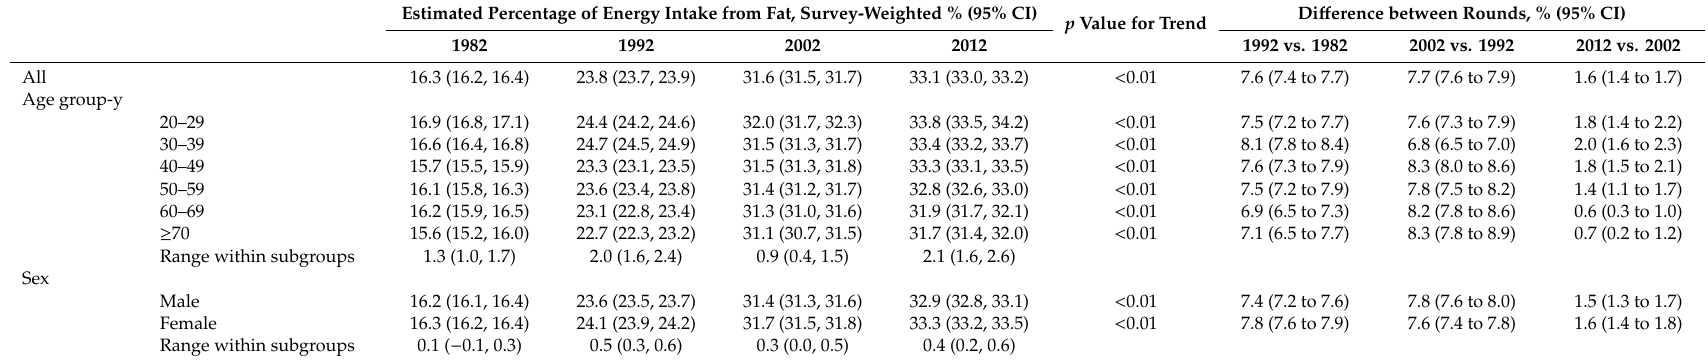
Table A2. Trends and Disparities in the Estimated Percentage of Energy Intake from Fat of Adults Aged 18 Years or Older by CNNS Round, 1982–2012 1 . Estimated Percentage of Energy Intake from Fat, Survey-Weighted % (95% CI)